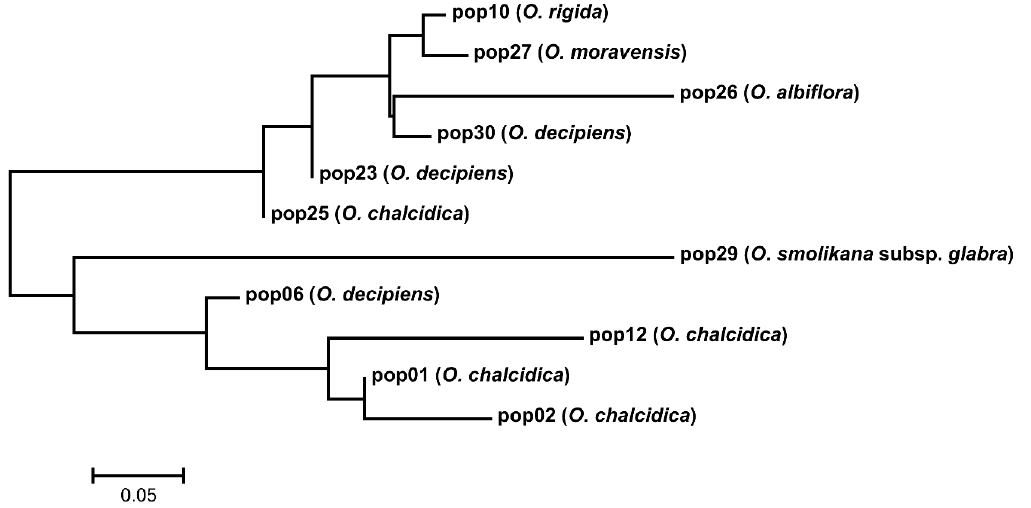
Figure 6. Neighbor-joining tree based on genetic distances between populations from the type localities of the taxa endemic to Albania and of those described from the same country but currently included in either O. chalcidica (pops. 1, 2, 12, 25) or O. decipiens (pops. 6, 23, 30; see Supplementary Table S1).